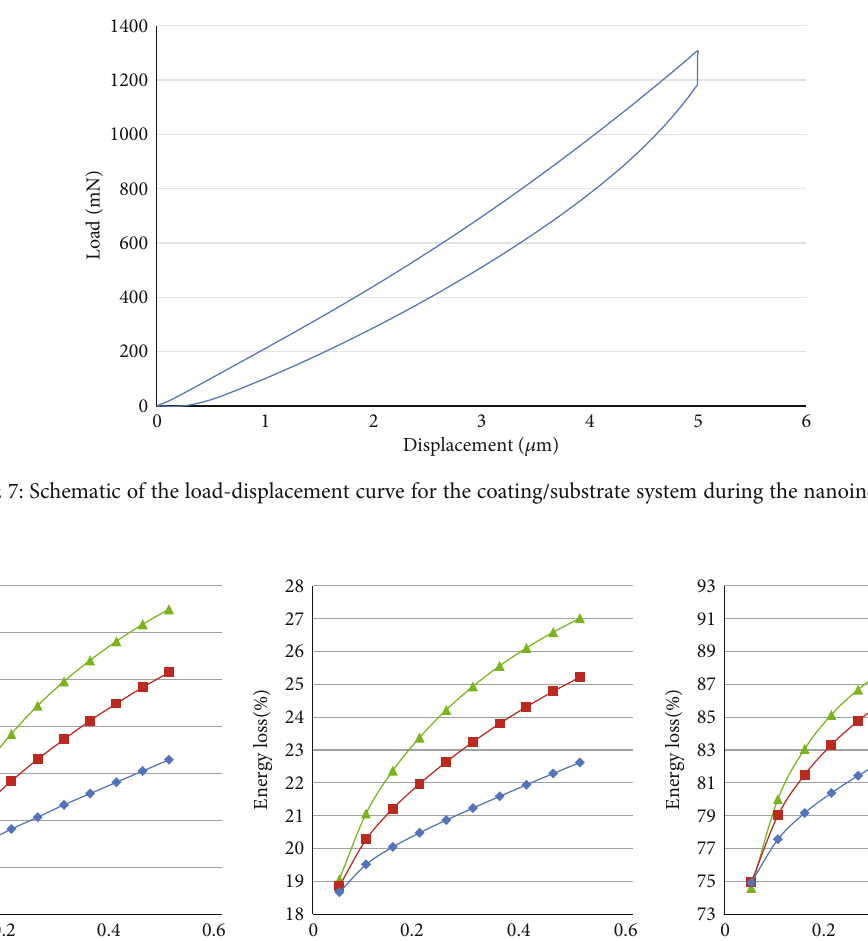
(substrate) equal to (a) 0.1, (b) 0.5, and (c) i